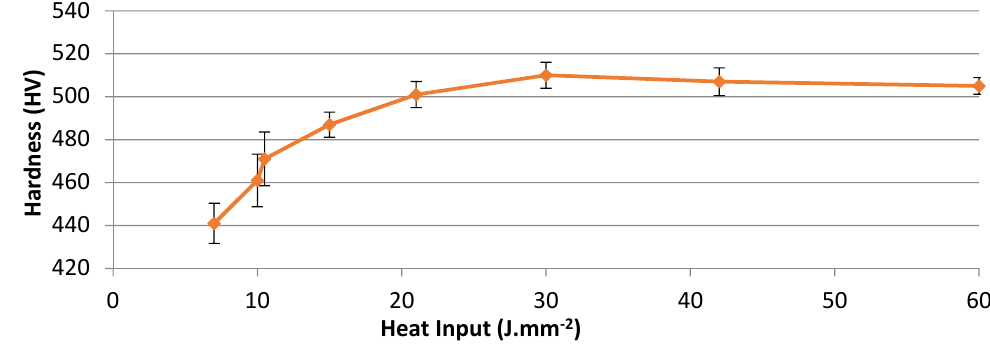
Figure 11. Heat input values versus average hardness values of laser surface treated AISI 416 samples. Error bars represent standard deviation.